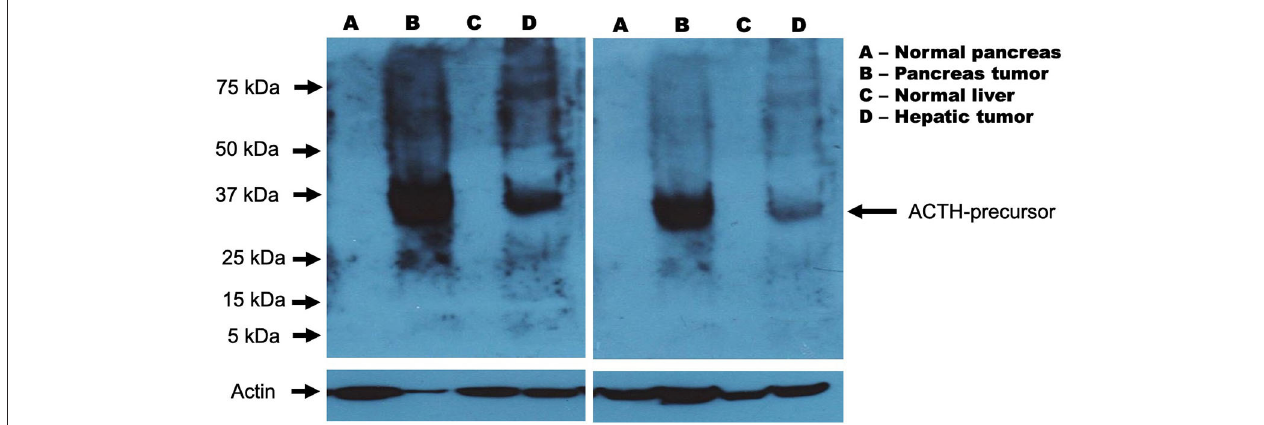
FIGURE 2 | Western blot analysis from samples of pancreatic tumor and liver metastasis. (A) Normal pancreas; (B) Pancreatic NET; (C) Normal liver; (D) Liver metastasis. Pancreatic and liver tissues were homogenized in the presence of RIPA buffer (PBS with detergents and protease inhibitors cocktail). Total protein concentration was determined using the commercial Bradford reagent assay (Bio-Rad, Hercules, CA). Whole protein (200 µ g) was used for the detection of the ACTH protein. Samples were first boiled in sample buffer (125mM Tris-HCl, pH 6.8, 1% v/w SDS, 10% v/v glycerol, 0.1% bromophenol blue, 2% v/v 2 alfa-mercaptoethanol) for 5min and separated by 12% SDS-PAGE. Then, the gels were transferred to PVDF membranes (Merck Millipore Corporation, Darmstadt Germany) using a Trans-Blot Cell system (Bio-Rad, Hercules, CA) in transfer buffer (25mM Tris, 190mM glycine, and 10% methanol) at 40V overnight. The following day, the membranes were blocked with non-fat dried milk (5%) dissolved in TBS buffer (150mM NaCl, 20mM Tris, and 0.1% Tween) and probed overnight at 4 ◦ C with rabbit monoclonal anti-ACTH antibody (Abcam, Cambridge UK) diluted 1:2,000 in TBS buffer with BSA (150mM NaCl, 20mM Tris, 0.1% Tween, and 1% BSA at pH 7.5). After washing, the membranes were incubated for 1h with anti-rabbit immunoglobulin-HRP (Thermo Scientific, Rockford, IL USA). The signals were detected by enhanced chemiluminescence using the SuperSignal TM system (Thermo Scientific, Rockford, IL USA) on X-ray film (Kodak, USA). As the control loaded, actin was